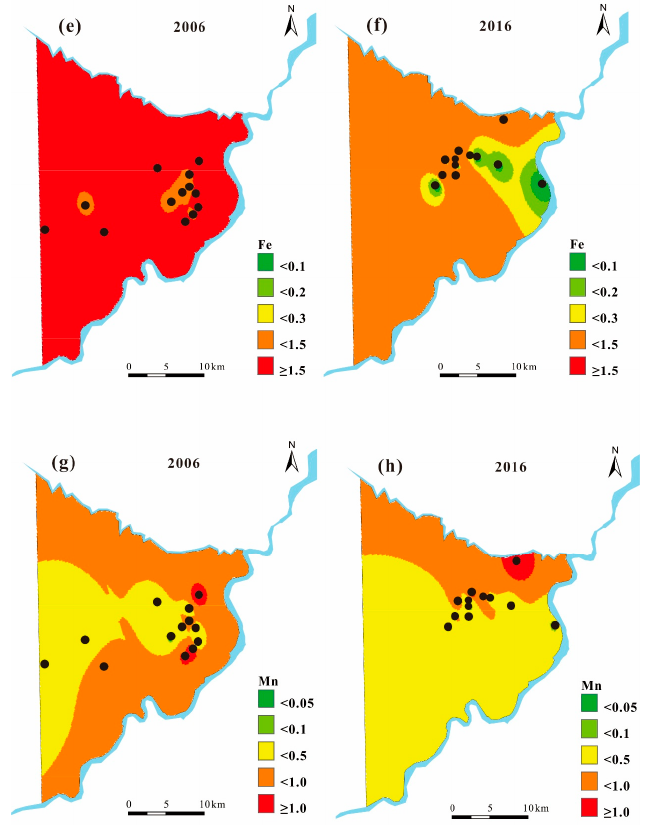
Figure 3. Spatial variation of NO 3 -N ( a , b ), NH 4 -N( c , d ), Fe( e , f ), and Mn ( g , h ) concentrations in 2006 and 2016.